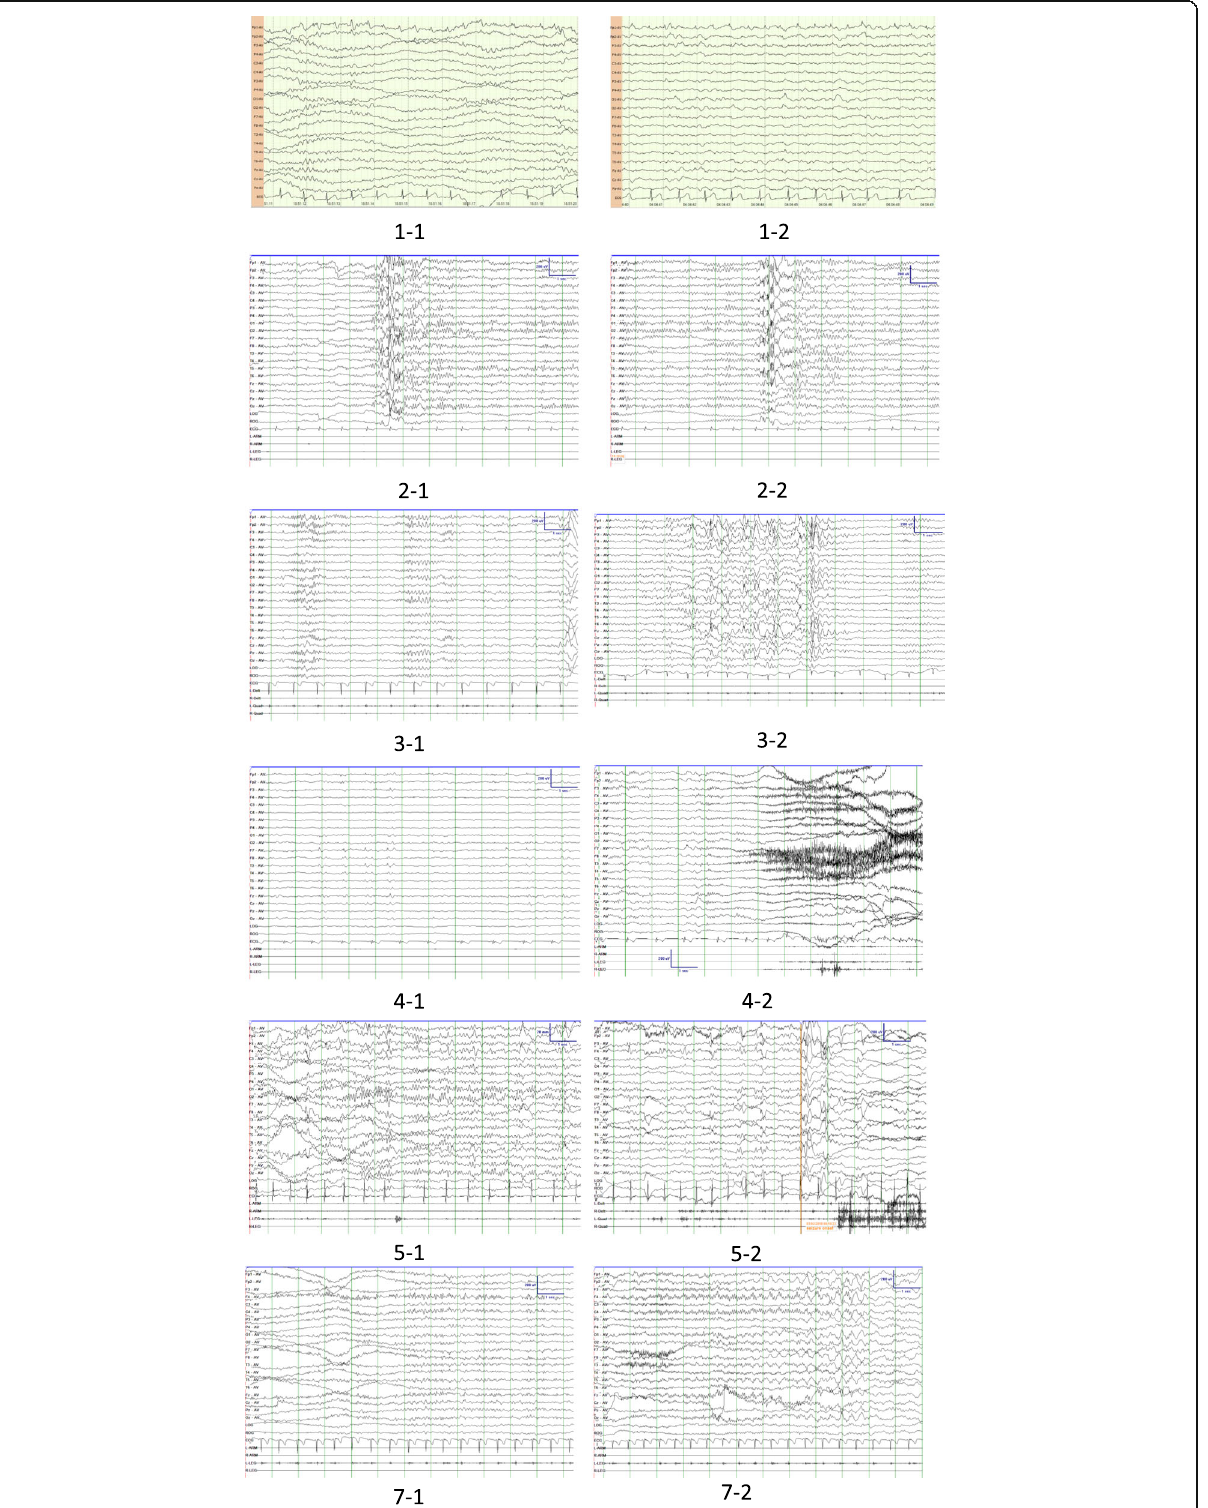
Fig. 3 EEG pictures for all patients. The first number represents the code of patient. While EEG of patient 6 was normal, it was not